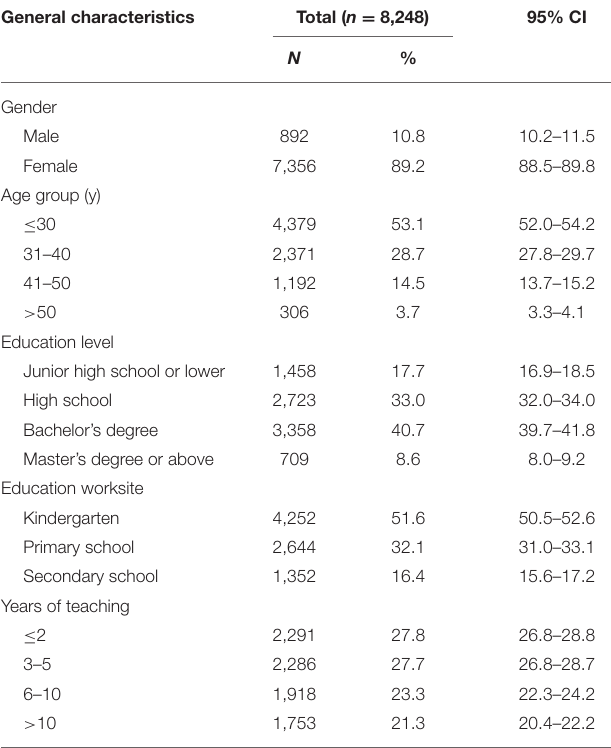
TABLE 1 | General characteristics of participants, Shenzhen, China, April 2020. General